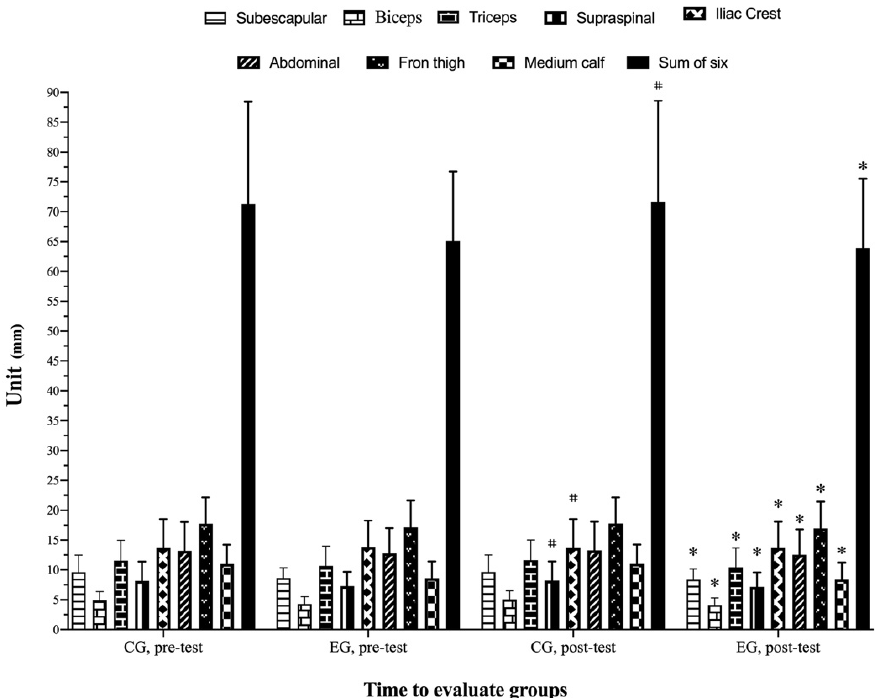
Figure 5. Change in skinfold variables assessment for each group and assessment stage. * Represents a statistically significant difference compared to the pre-test with the superiority of the EG ( p < 0.05). # Represents a statistically significant difference compared to the pre-test with the superiority of the CG ( p < 0.05). EG: experimental group; CG: control group.